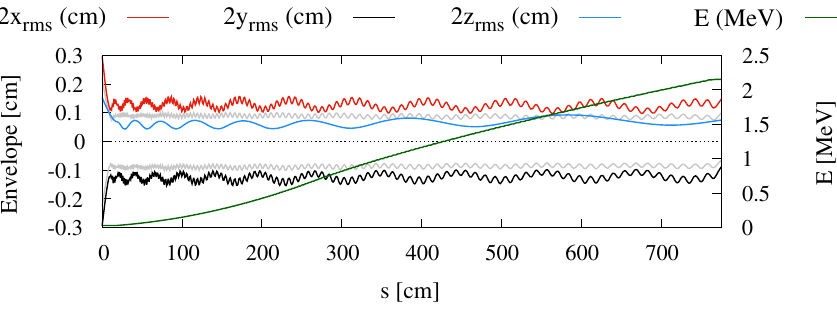
FIG. 3. 2-term TRANSOPTR simulation of the ISAC-RFQ, showing 2 rms envelopes on the left-hand vertical axis, with the y -envelopes shown as negative values for clarity. The simulation runs from the start of the RFQ tank at s ¼ 0 . Two separate envelopes are shown, corresponding to a matched and a mismatched case, in the transverse dimensions, with values from Table II. The mismatched case highlights the betatron oscillation and is shown in color including the longitudinal envelope. The beam energy is shown on the right-hand vertical axis. The transversely matched envelope is shown in light grey.